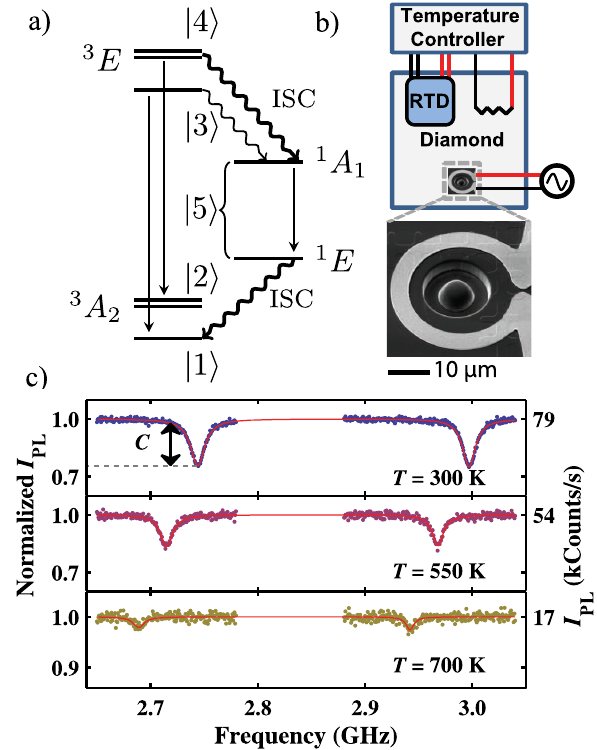
FIG. 1. (a) Orbital diagram showing the triplet ( 3 A 2 and 3 E ) and singlet ( 1 A 1 and 1 E ) electronic states. The straight lines represent optical transitions and the snaked lines represent non- radiative intersystem crossings (ISC). Bra-ket notation denotes the effective levels used to model the photoluminescence inten- sity ( I PL ) and electron spin resonance (ESR) contrast. Level j 2 i ( j 4 i ) is a grouping of the 3 A 2 ( 3 E ) m s ¼ (cid:2) 1 sublevels and j 5 i is an effective singlet level. (b) Sample schematic showing the resistive heater and resistive temperature detector (RTD), the solid immersion lens (SIL), and the antenna. The scanning electron microscope image shows the SIL and antenna. (c) I PL of a single NV center versus applied microwave frequency. Lorentzian dips with normalized amplitude C are observed at the spin resonance frequencies ( B (cid:3) 45 G ). The left (right) axis shows the normalized (absolute) I PL to illustrate the temperature- dependent decrease in C and I PL . The red lines are two- Lorentzian fits. The crystal field splitting ( D ) is the average of the resonance frequencies. The measurements were performed at high microwave power to saturate the spin transitions.